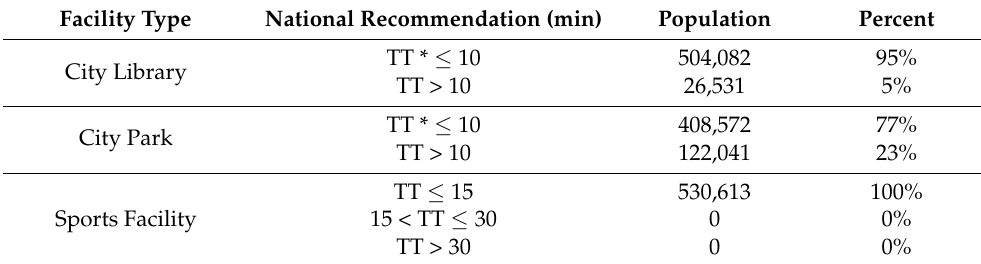
Table 6. Population by legend—vehicle